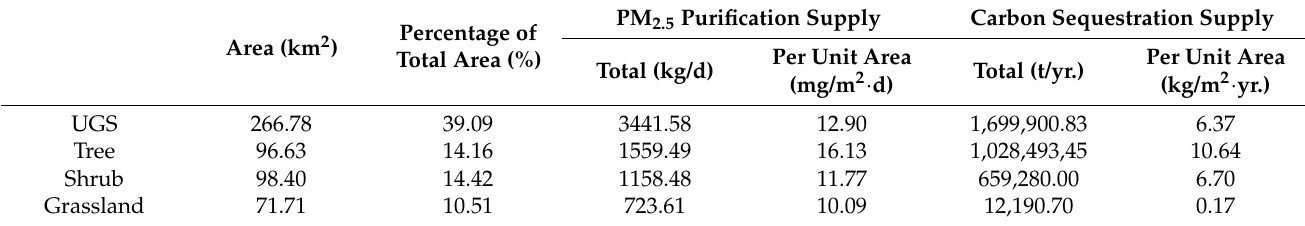
Table 3. Evaluation results of the urban green spaces (UGSs) and their ecosystem services (ESs) in study area. PM 2.5 Purification Supply Carbon Sequestration Supply Percentage of Area (km 2 ) Per Unit Area Per Unit Area Total Area (%) Total (t/yr.) Total (kg/d) (kg/m 2 · yr.) (mg/m 2 · d) UGS